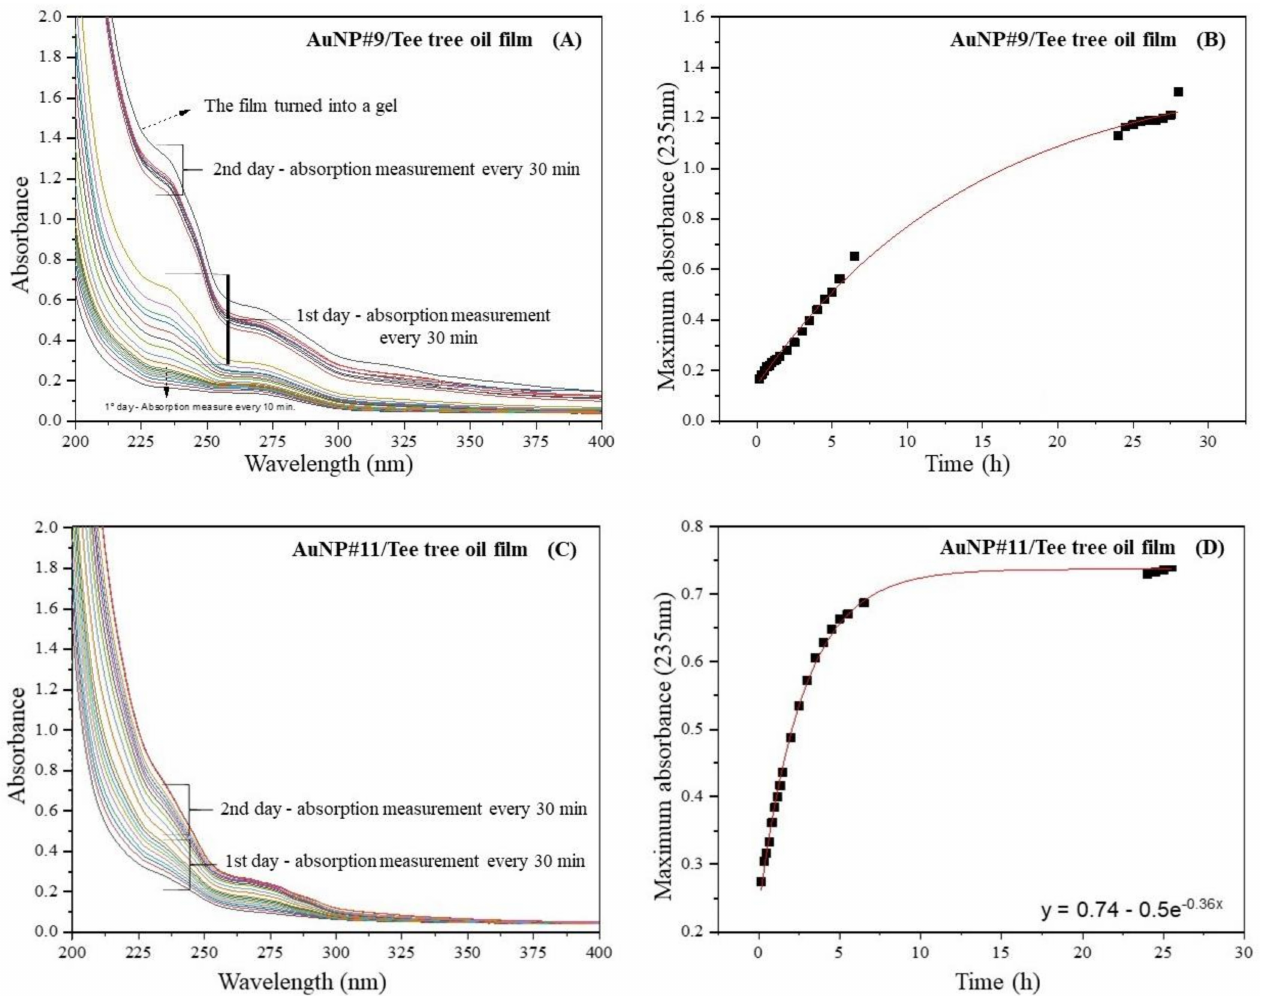
Figure 4. ( A ) UV-vis spectra of the release process of tea tree oil from the AuNP#2- film; ( B ) absorbance maxima at 235 nm of the release process from the AuNP#9-film; ( C ) UV-vis spectra of the release process of tea tree oil from the AuNP#11-film; and ( D ) absorbance maxima at 235 nm of the release process from the